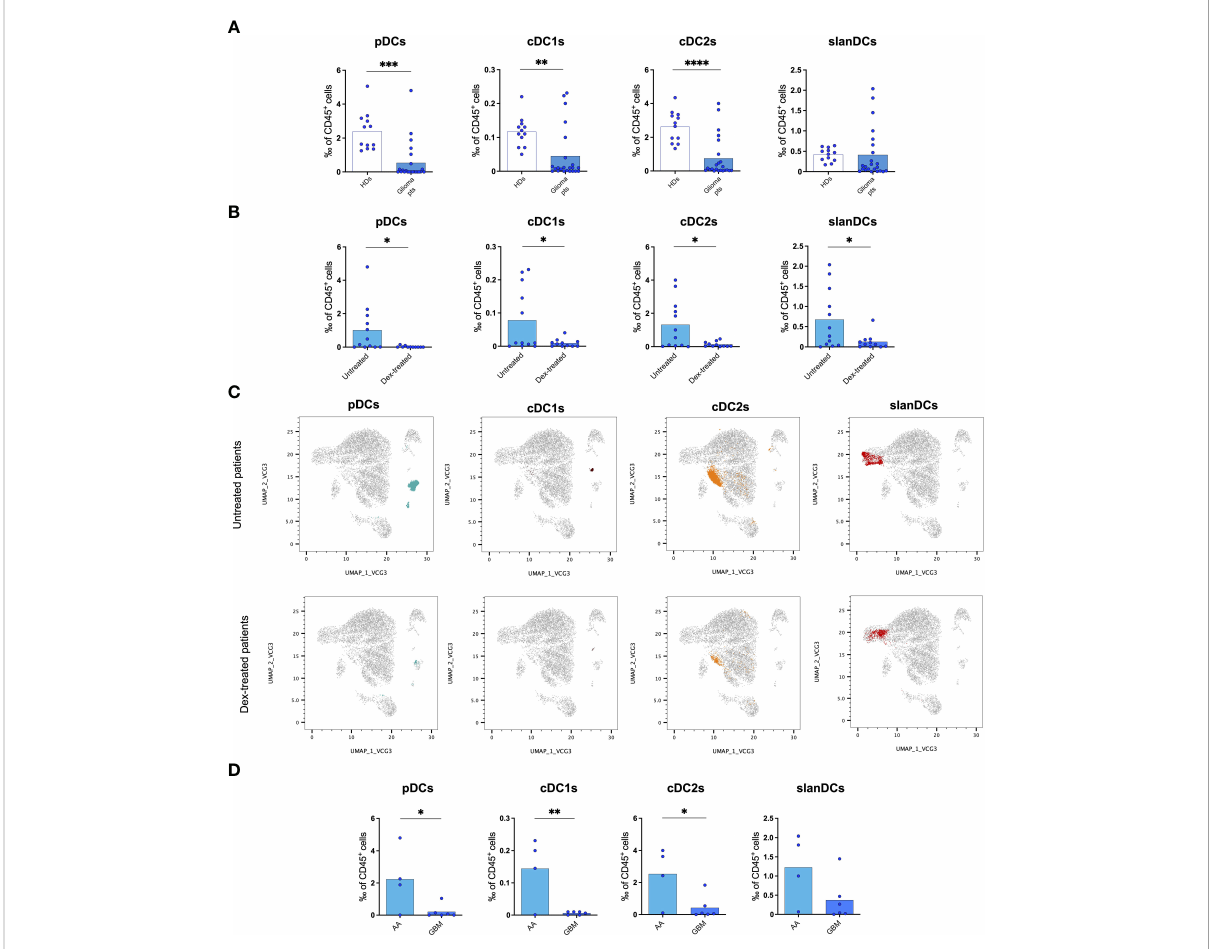
FIGURE 1 Flow cytometric analysis of PBDC subsets showing a reduction of circulating DCs in glioma patients. (A) Frequency of PBDC subsets in healthy donors (HDs, n=12) and glioma patients (Glioma pts, n=23). (B) Frequency of PBDC subsets in glioma patients either untreated (Untreated, n=12) or treated with dexamethasone (Dex-treated, n=11). Data expressed as per-thousand ( ‰ ) of CD45 + cells. Each symbol represents a single sample. In each series, the mean is shown. *p<0.05, **p<0.01, ***p<0.001, ****p<0.0001, calculated using the t-test. (C) UMAP plots showing the clustering of PBDC subsets in untreated and dex-treated glioma patients. Each plot shows a single DC subset as identi fi ed with manual gating strategy. Viable circulating CD45 + /lin − /HLA-DR + cells of down-sampled, concatenated fi les obtained from all glioma patients are shown in gray. pDCs are highlighted in dark turquoise, cDC1s in brown, cDC2s in orange, slanDCs in red. (D) Frequency of PBDC subsets in untreated IDH-wildtype glioma patients strati fi ed based on histopathological diagnosis (anaplastic astrocytoma: AA, n=4; glioblastoma: GBM,